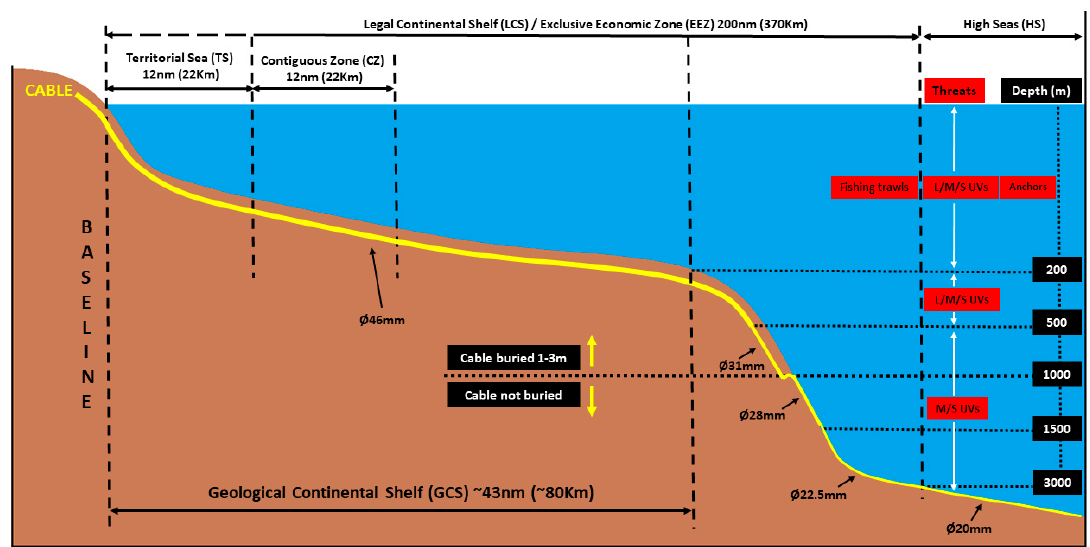
Figure 5. Schematic synthesis (not linearly scaled) including the most likely identified threats and the different components of the underwater cable environment (Ø = cable diameter). L/M/S UVs means large/medium/small underwater vehicles.